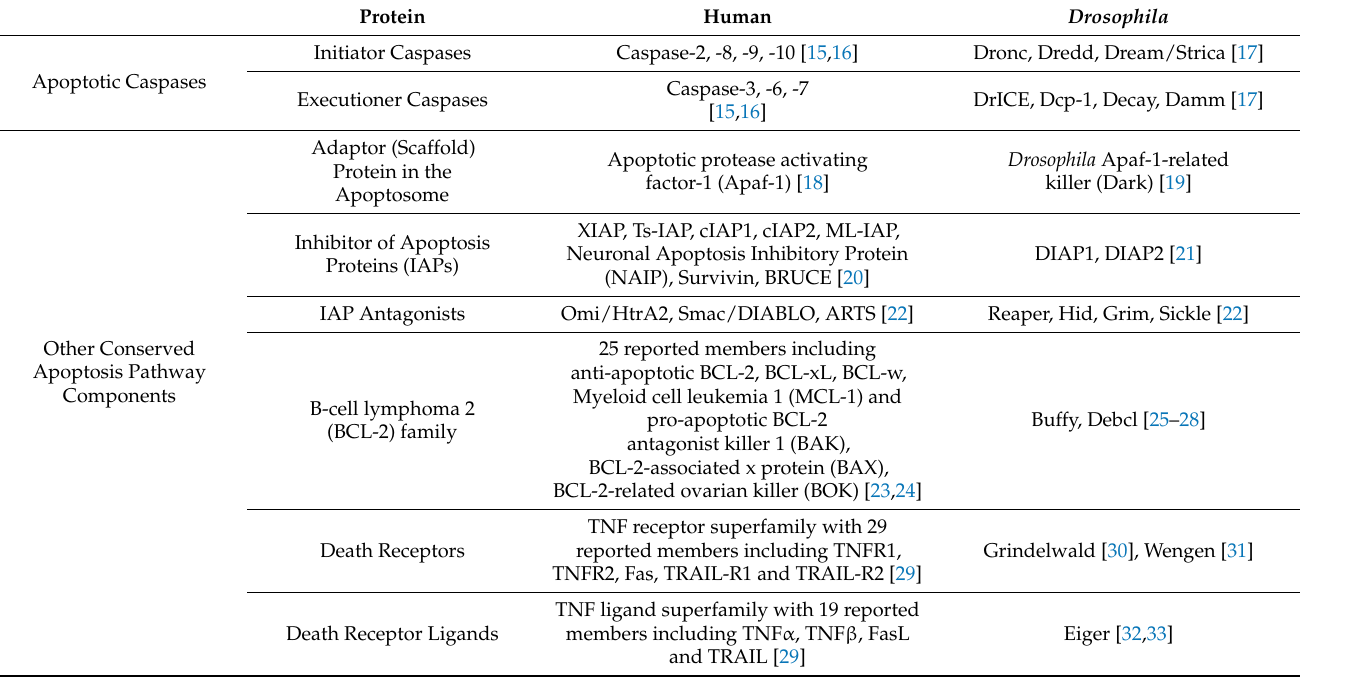
Table 1. Caspases and conserved components of the apoptosis pathway.in humans and Drosophila . Protein